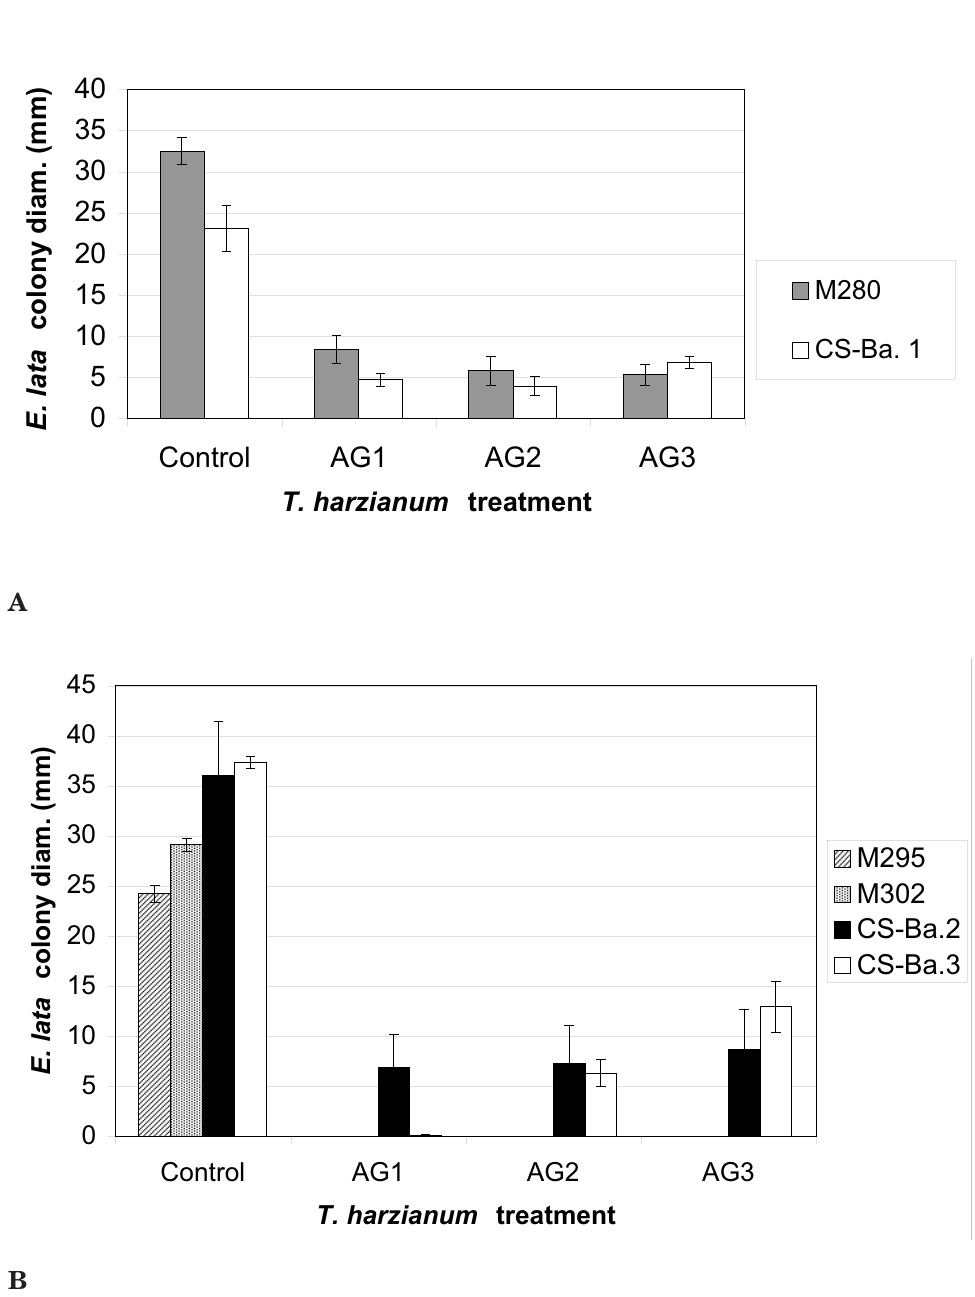
Fig. 2. Inhibition of growth of E. lata on PDA by non-volatile antibiosis by T. harzianum . Mycelial plugs of T. harzianum were grown on cellophane over PDA for 2 days in the dark at 22–25°C. The cellophane and plugs were replaced with plugs of E. lata and plates incubated for another 4 or 6 days. Y-axis denotes the average colony diam. (minus the inoculum plug) for eight replicates per treatment. Bars denote standard errors. A. Two isolates of E. lata incubated for 4 days on medium containing diffusible metabolites. B. Four isolates of E. lata incubated for 6 days on medium containing diffusible